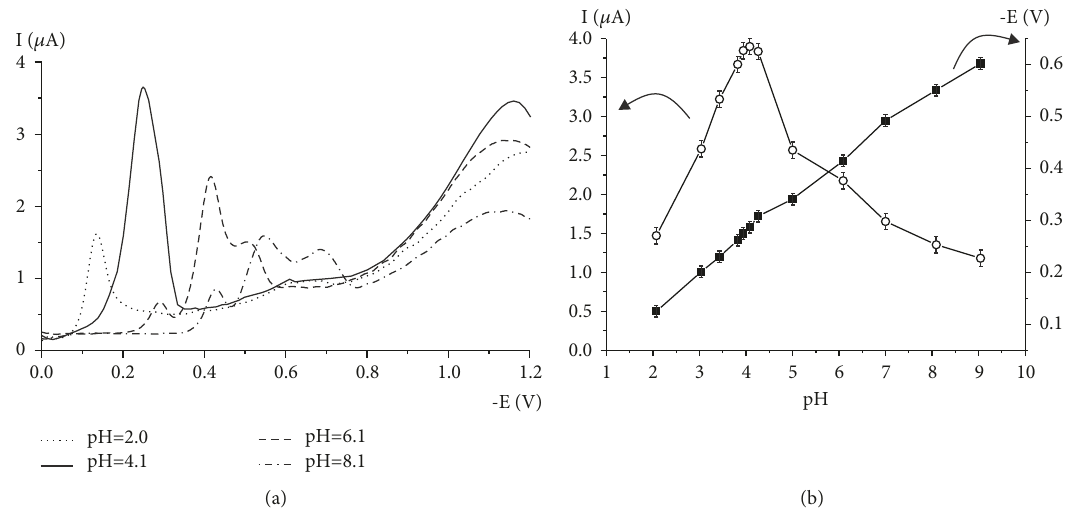
Figure 3: Polarogramms PC (a) and dependence of polarographic characteristics of derivatives at different pH (b) using phosphate buffer, C PC = 5 ⋅ 10 −5 mol ⋅ L −1 , C PMS = 10 −4 mol ⋅ L −1 , C buffer =0.2 mol ⋅ L −1 , duration of oxidation 10 min., and T= 70 ∘ b .